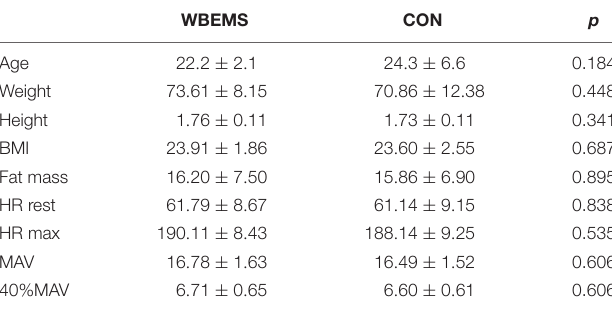
TABLE 1 | Characteristics of the participants in the study ( n =